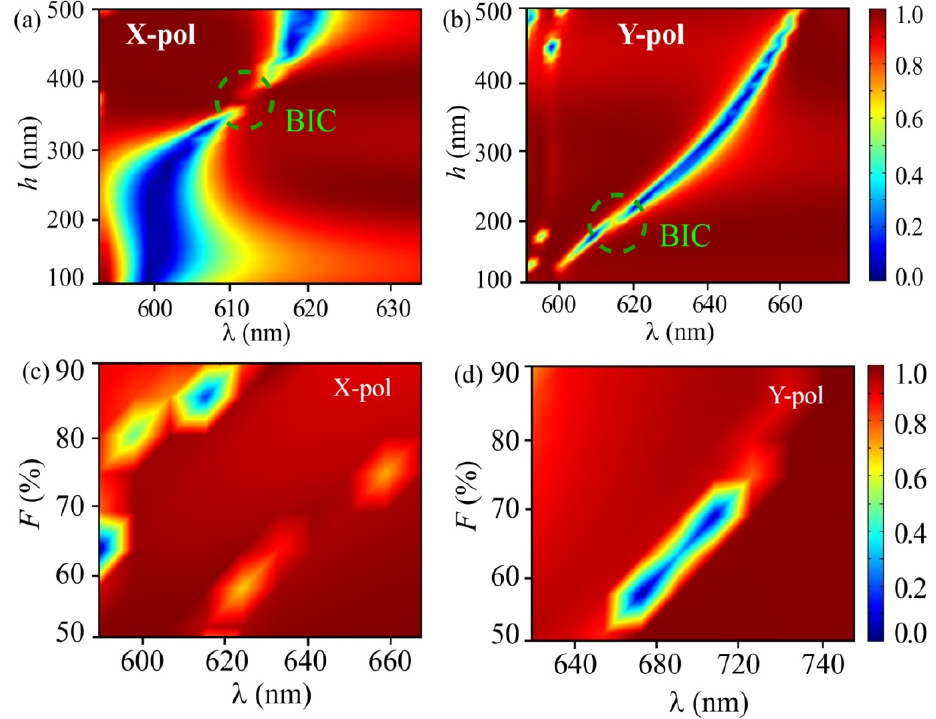
Figure 3. Contour plot of grating optimization. ( a , b ) shows contours plots of change in the λ with grating height ( h ) from 100–500 nm ( c , d ) show the change in λ with the fill factor ( F ) from 50–90% for X-pol and Y-pol light, respectively.